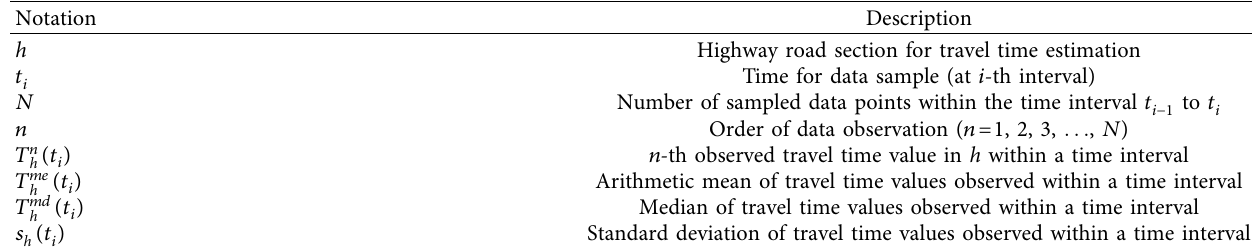
Table 1: Descriptions of related variables.